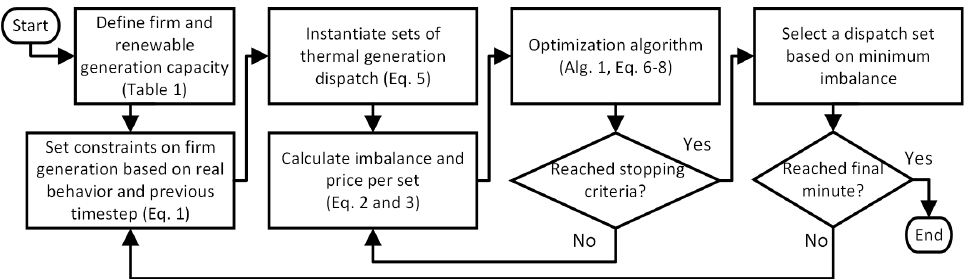
Figure 4. Proposed procedure for hybrid economic dispatch and clustered unit commitment towards analyzing the limits of renewable generation with operational flexibility. Per scenario, simulations were run chronologically for a year of minutely data to capture high renewable